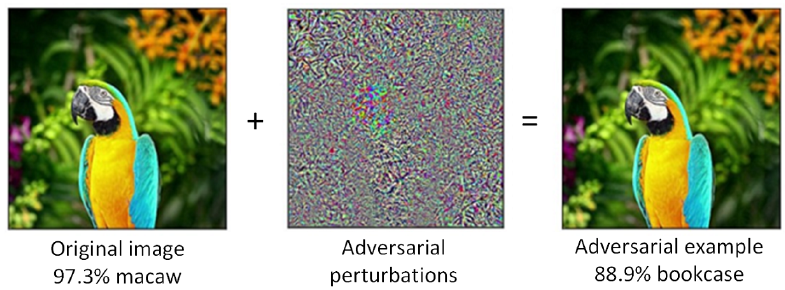
Figure 1. DNN provides the wrong prediction with high confidence by adding imperceptible perturbations to the original